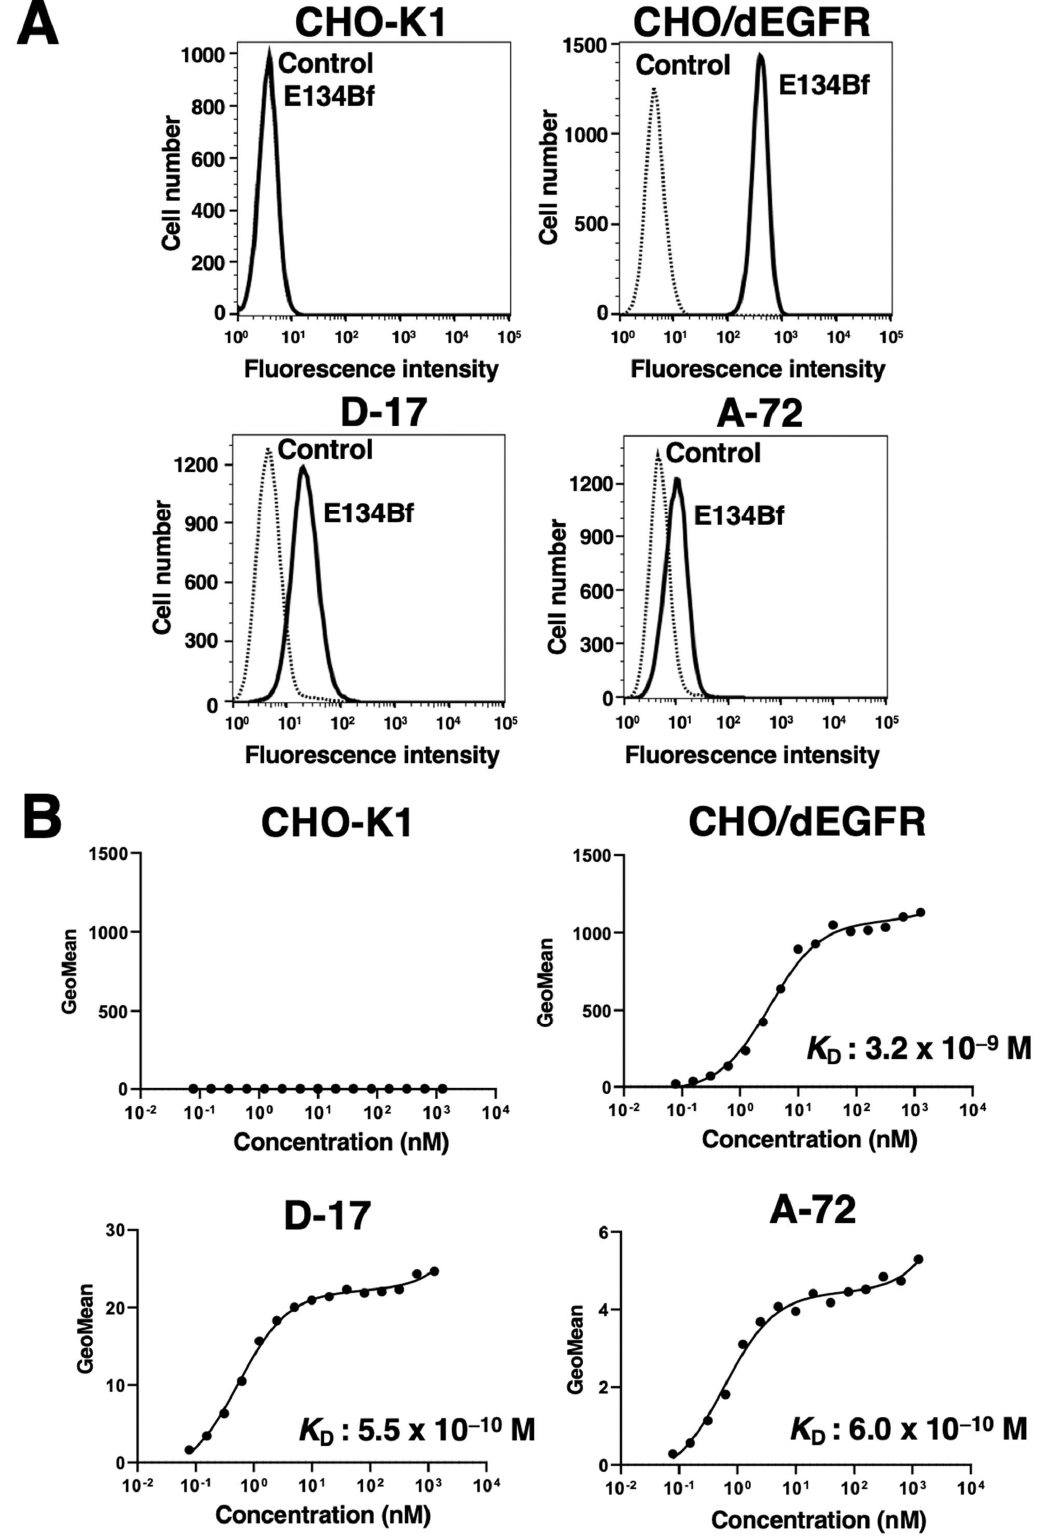
Figure 2. Flow cytometry using E134Bf. ( A ) CHO-K1, CHO/dEGFR, D-17, and A-72 cells were treated with E134Bf or buffer control, followed by FITC-conjugated anti-dog IgG. ( B ) Determination of the binding affinity of E134Bf for CHO-K1, CHO/dEGFR, D-17, and A-72 cells via flow cytometry. The cells were suspended in 100 µ L of serially diluted E134Bf, followed by the addition of FITC-conjugated anti-dog IgG. Fluorescence data were collected using the EC800 Cell